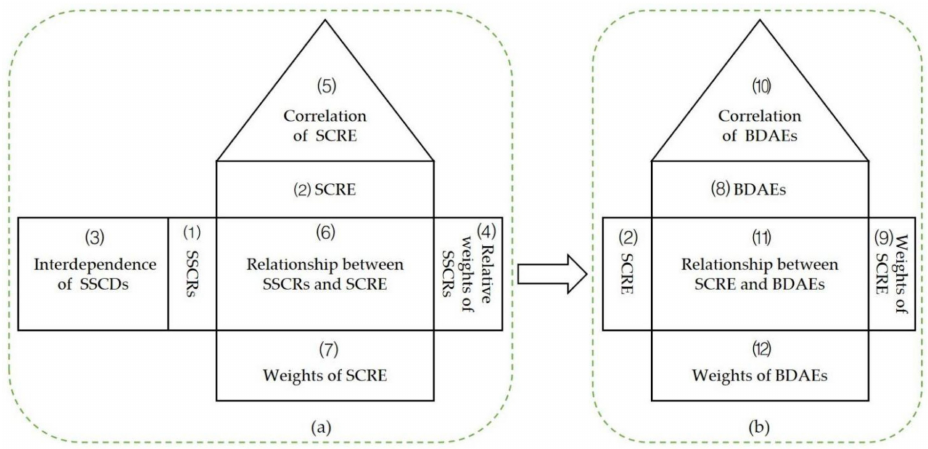
Figure 1. Two-stage HoQs. ( a ) The first HoQ; ( b ) The second